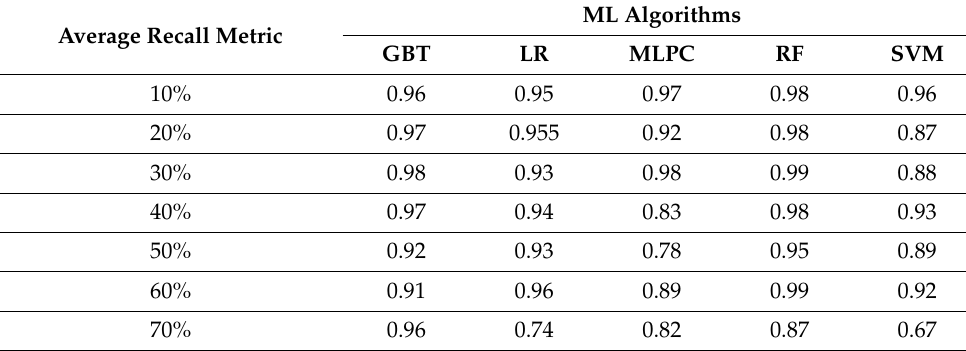
Table 6. Model recall results under different